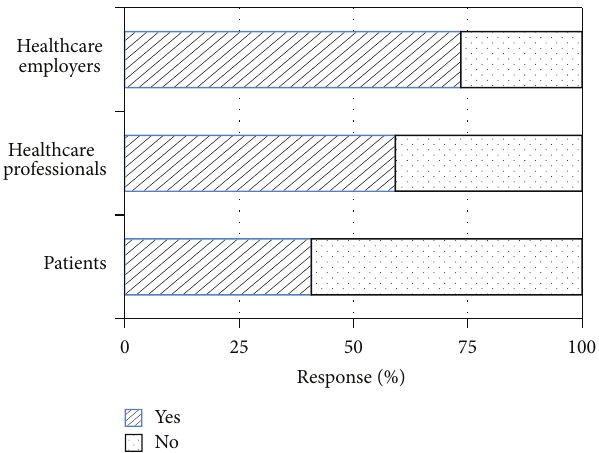
Figure 5: Expectations of fellowship-certification by category, as perceived by residents. Horizontal percentage-stacked bars illustrat- ing resident perceptions on whether various populations expected them to be fellowship-certified. Residents considered healthcare employers to be the most likely population to require fellowship- certification from